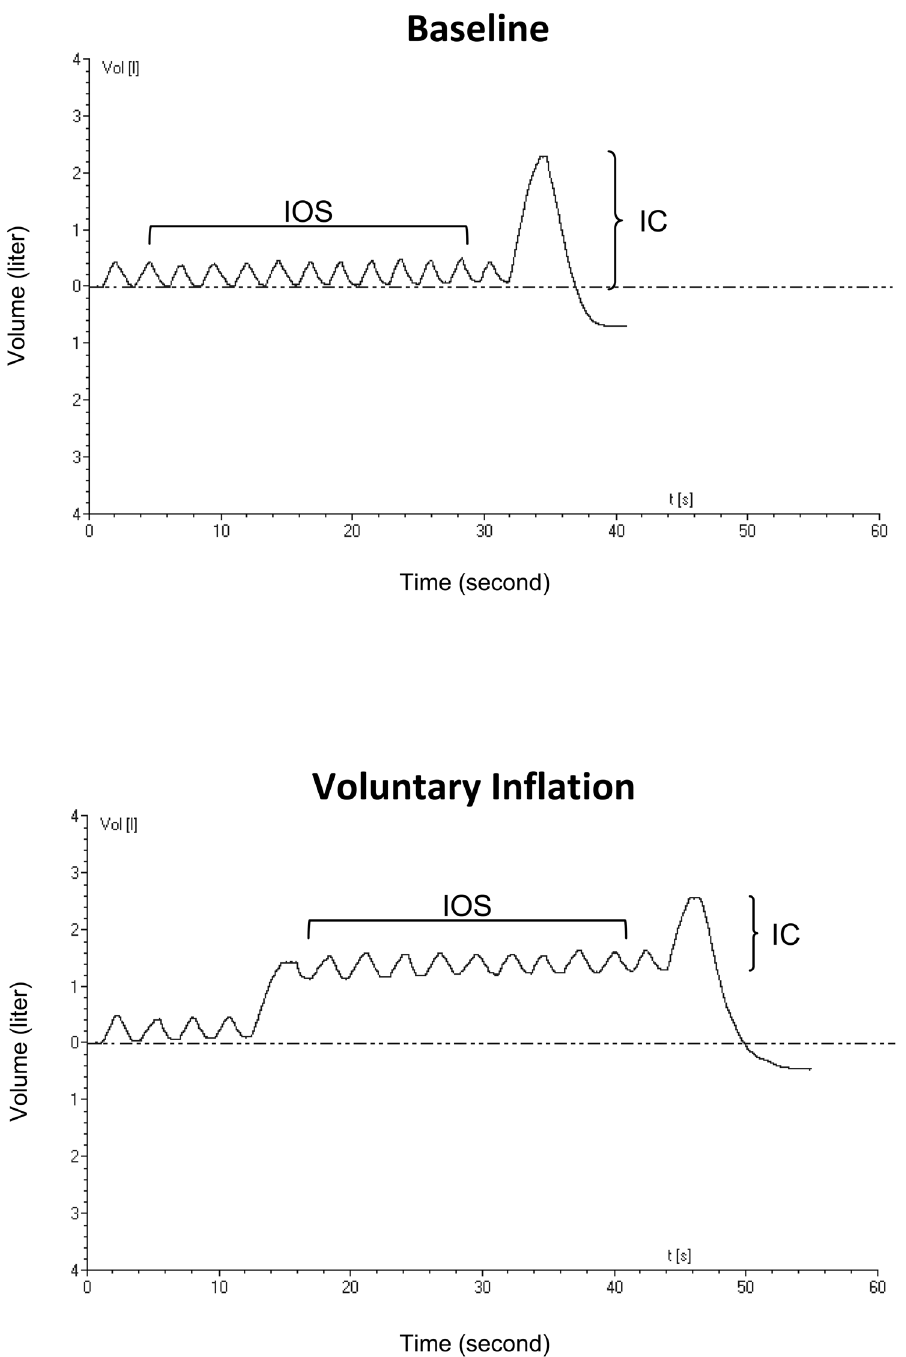
Figure 1. Image obtained from the oscillometry system illustrating measurement at baseline FRC (top panel) and following voluntary inflation targeted to achieve an end expiratory lung volume similar to the predicted FRC (bottom